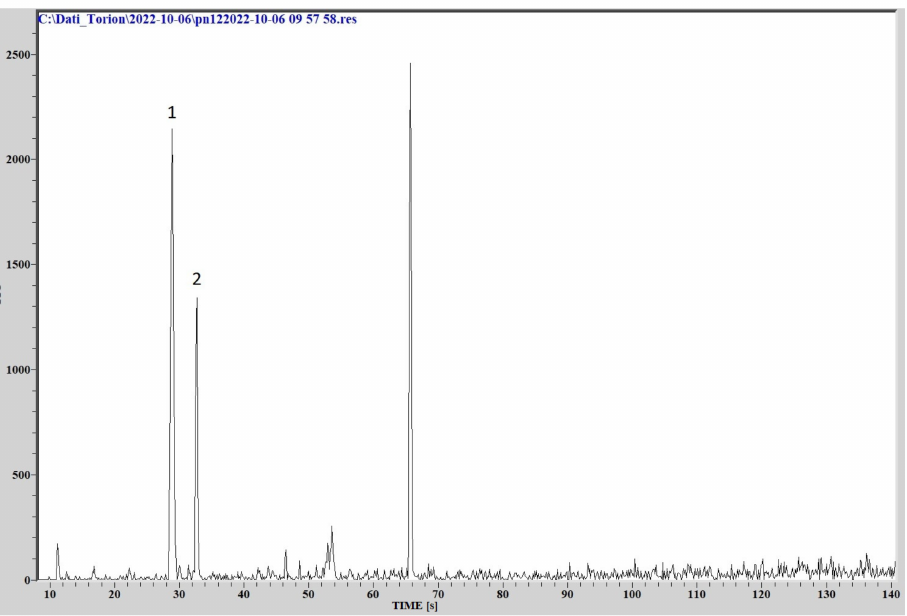
Figure 9. Chromatogram from L. pneumophila . (1) 1-butanol- 3methyl, (2) Methyl isovalerate. Regarding L. species , the emission of volatile organic compounds seems to be lower both in number and intensity of peaks, but the main substance detected was identified as 1 butanol-3 methyl, the same as for L. pneumophila . The chromatogram is reported in Figure